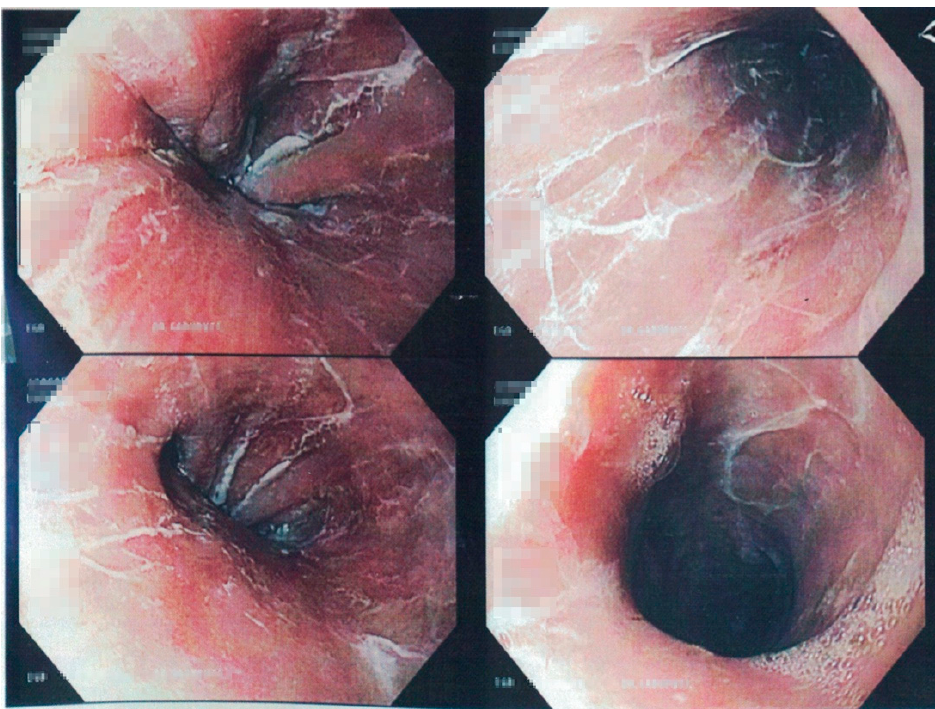
Figure 1. Esophagogastroduodenoscopy (EGD) showing superficial mucosal desquamation in entire esophagus suggestive of esophagitis dissecans superficialis.